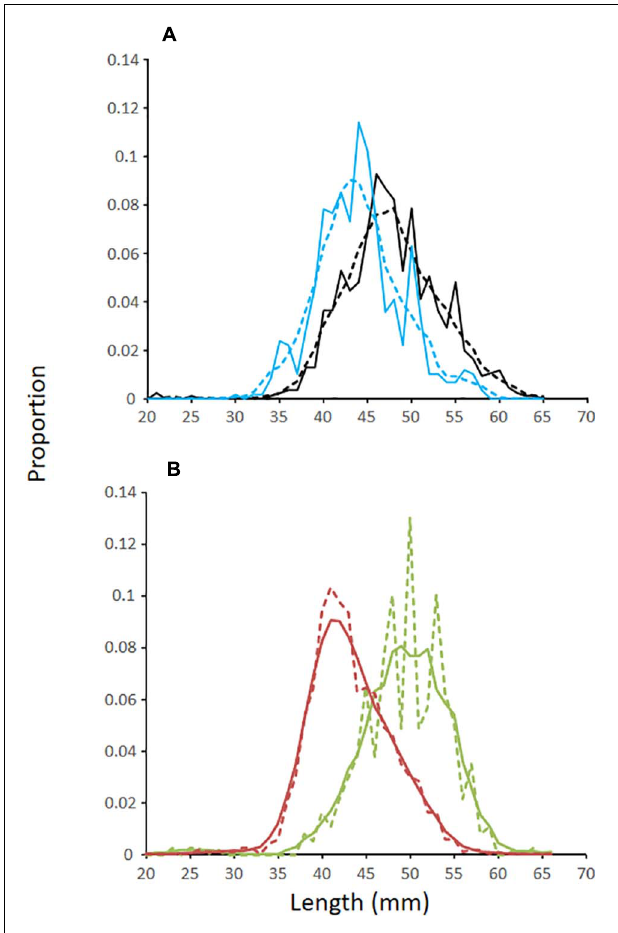
FIGURE 4 | (A) Length-frequency distributions of Antarctic krill from (A) the diets of penguins foraging off Cape Shirreff (black lines) and King George Island (blue lines) during the austral summer of 2018/19. (B) Length-frequency distributions of krill from net tows conducted during ship-based surveys in 2018/19 where red lines represent data from the Bransfield Strait and the green lines represent data collected on the West Shelf and within the restricted area surveyed by a glider. Solid lines are raw data, and dashed lines are smooths based on a five-point running average.